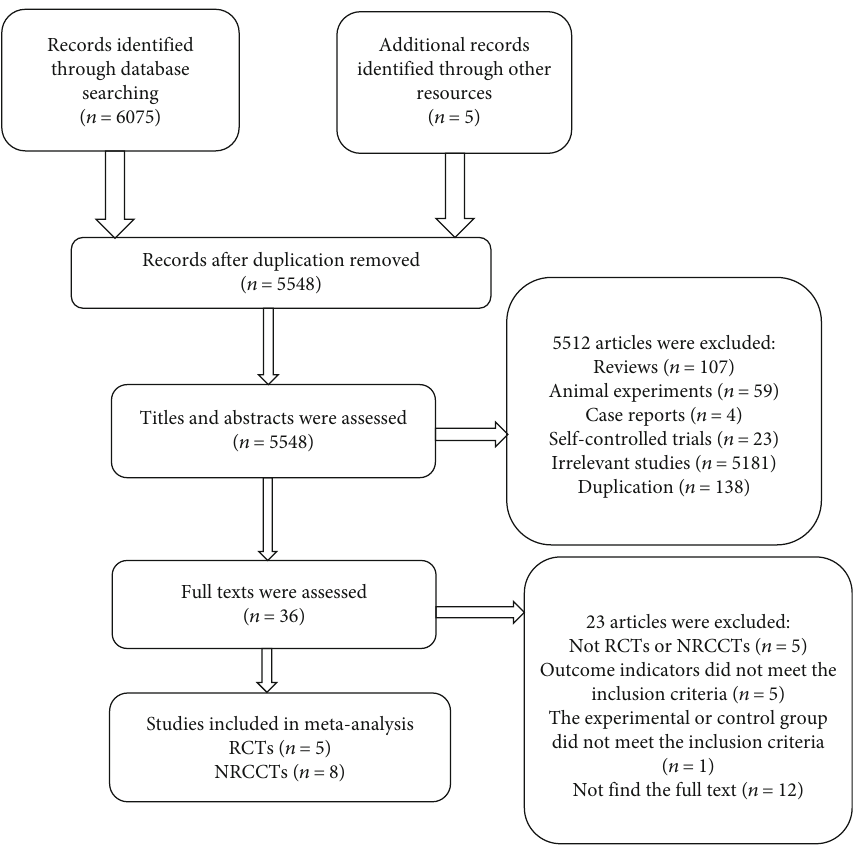
Figure 1: Flow chart of the selection of studies for the present systematic review and